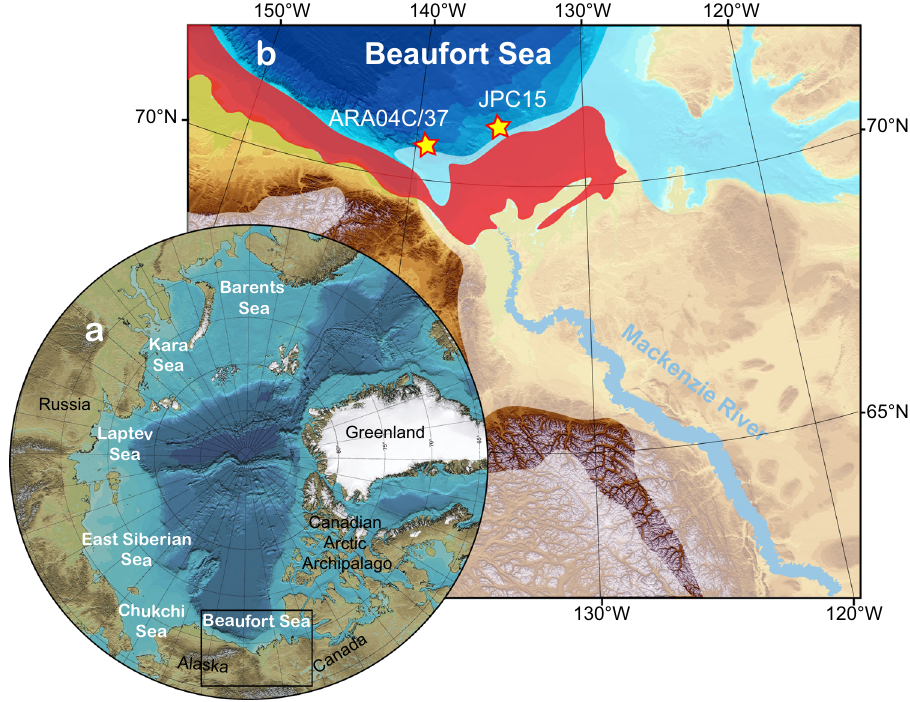
Fig. 1 | Overview of the Arctic Ocean and core locations in the Canadian BeaufortSea.a overviewoftheArcticOceanandthestudyarea(blackbox). b core locations of ARA04C/37 and JPC15 in this study are indicated by yellow stars and theMackenzieRiverisoutlinedbyablueline.Theredareabetweenthepaleocoast